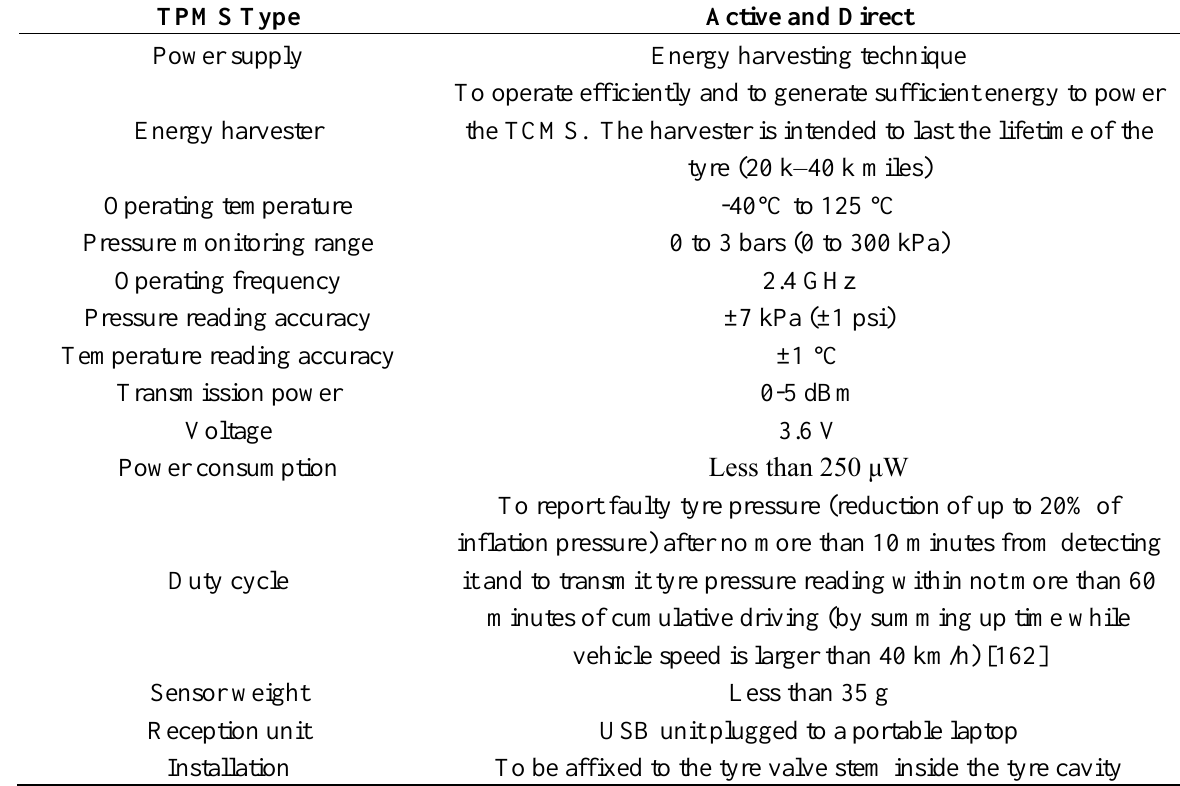
Table 6. TCMS requirements and design